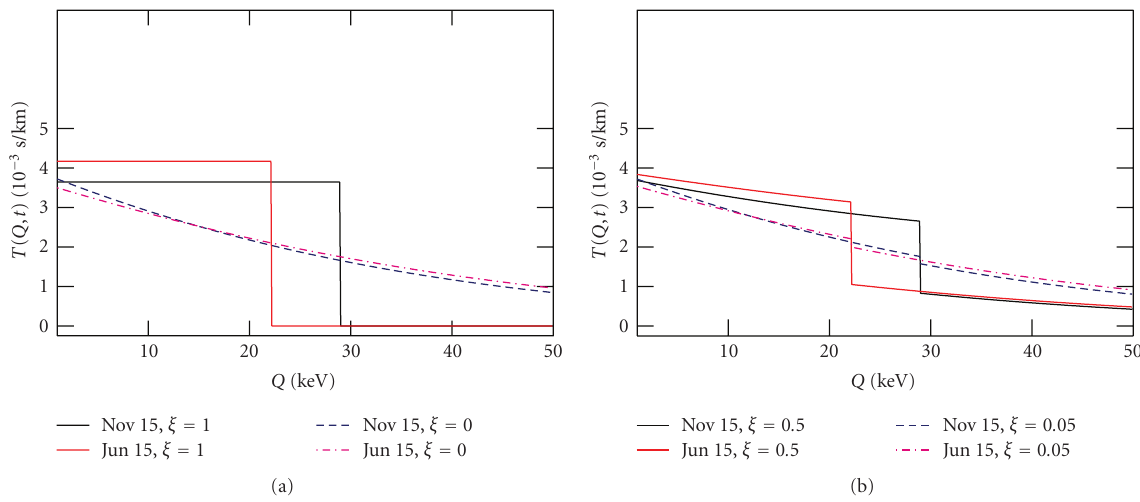
Figure 4: Mean inverse speed T ( Q , t ). Panel (a) shows the variation for the caustic flow (a) and for the Maxwellian. Panel (b) shows a combination of the two. Shown are measurements in November and